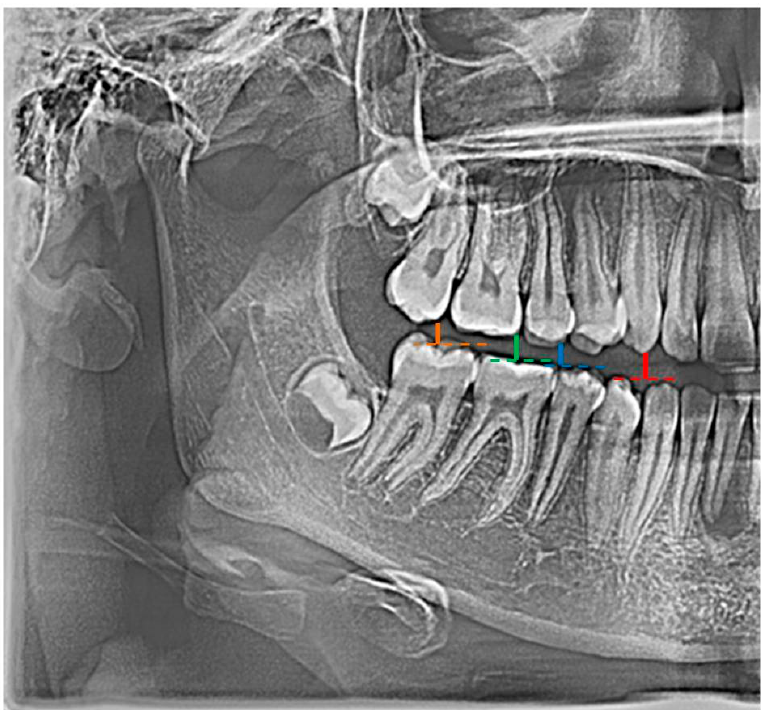
Figure 1. Example graphical representation of indicators: X01 (color: red |C13C43|; blue |C15C45|), X02 (color: red |C13C43|; green |C16C46|), and X03 (color: red |C13C43|; orange |C17C47|).